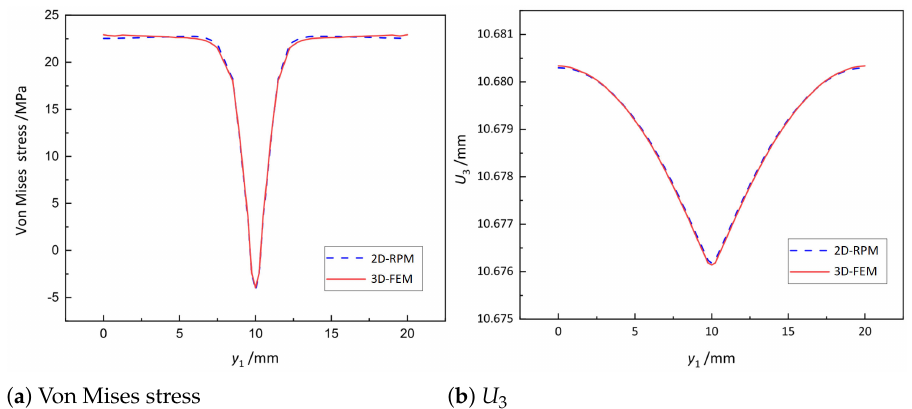
Figure 10. Comparison of von Mises stress and U 3 distribution along Path 1 within the unit cell at the geometric center of the